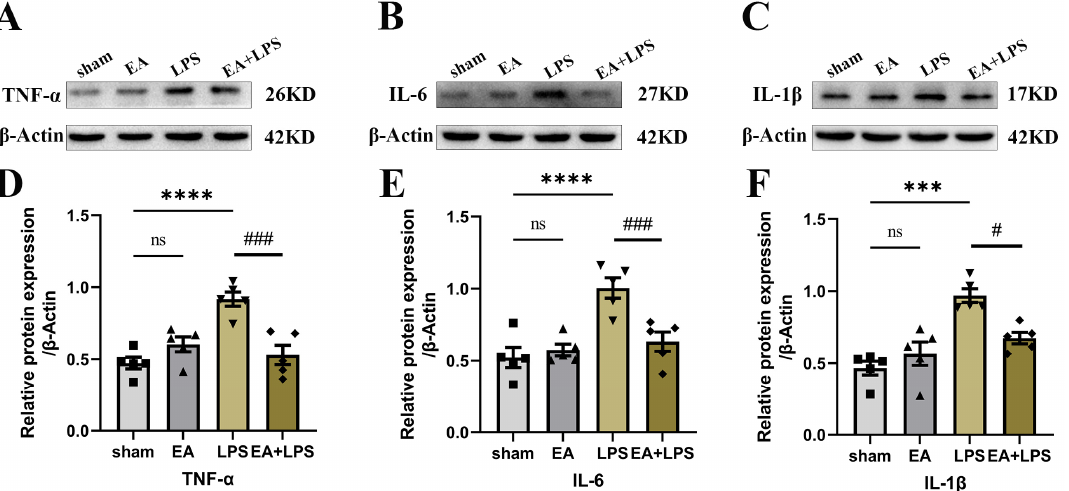
Figure 4. EA decreased pro-inflammatory cytokines in the hippocampus: n = 5 per group. ( A ) Representative blots of TNF- α . ( B ) Representative blots of IL-6. ( C ) Representative blots of IL-1 β . ( D ) Quantification of the expression level of TNF- α . ( E ) Quantification of the expression level of IL-6. ( F ) Quantification of the expression level of IL-1 β . Data are presented as means ± SEM. Compared with the sham group, *** p < 0.001, **** p < 0.0001; compared with the LPS group, # p < 0.05, ### p < 0.001. (cid:4) , (cid:78) , (cid:72) , : Represents the individual value of the rats in each group. Abbreviations: EA, electroacupuncture; LPS, lipopolysaccharide; ns, no significant